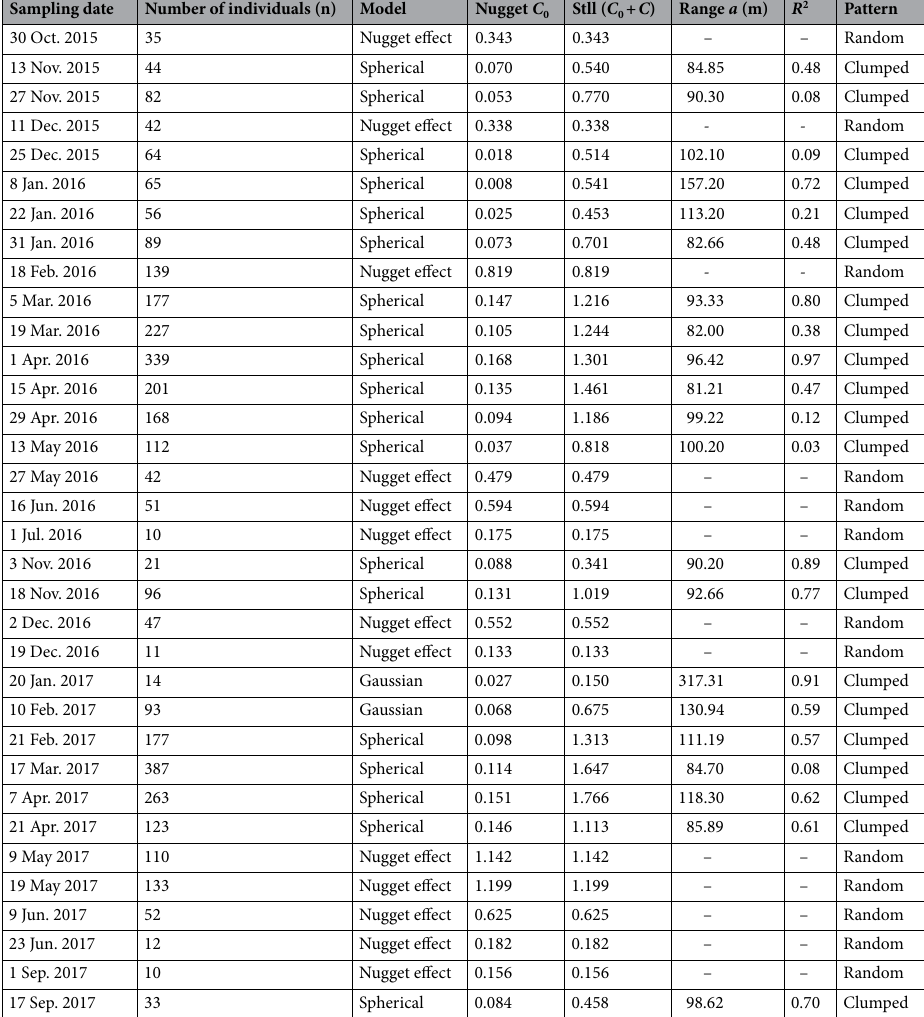
Table 2. Spatial distribution patterns of P. xylostella populations in fine-scale agricultural landscape in different sampling time.